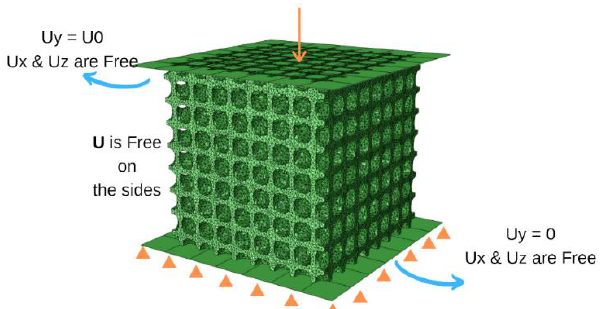
Fig. 3. Example of FE mesh and boundary conditions for the Schwarz diamond numerical